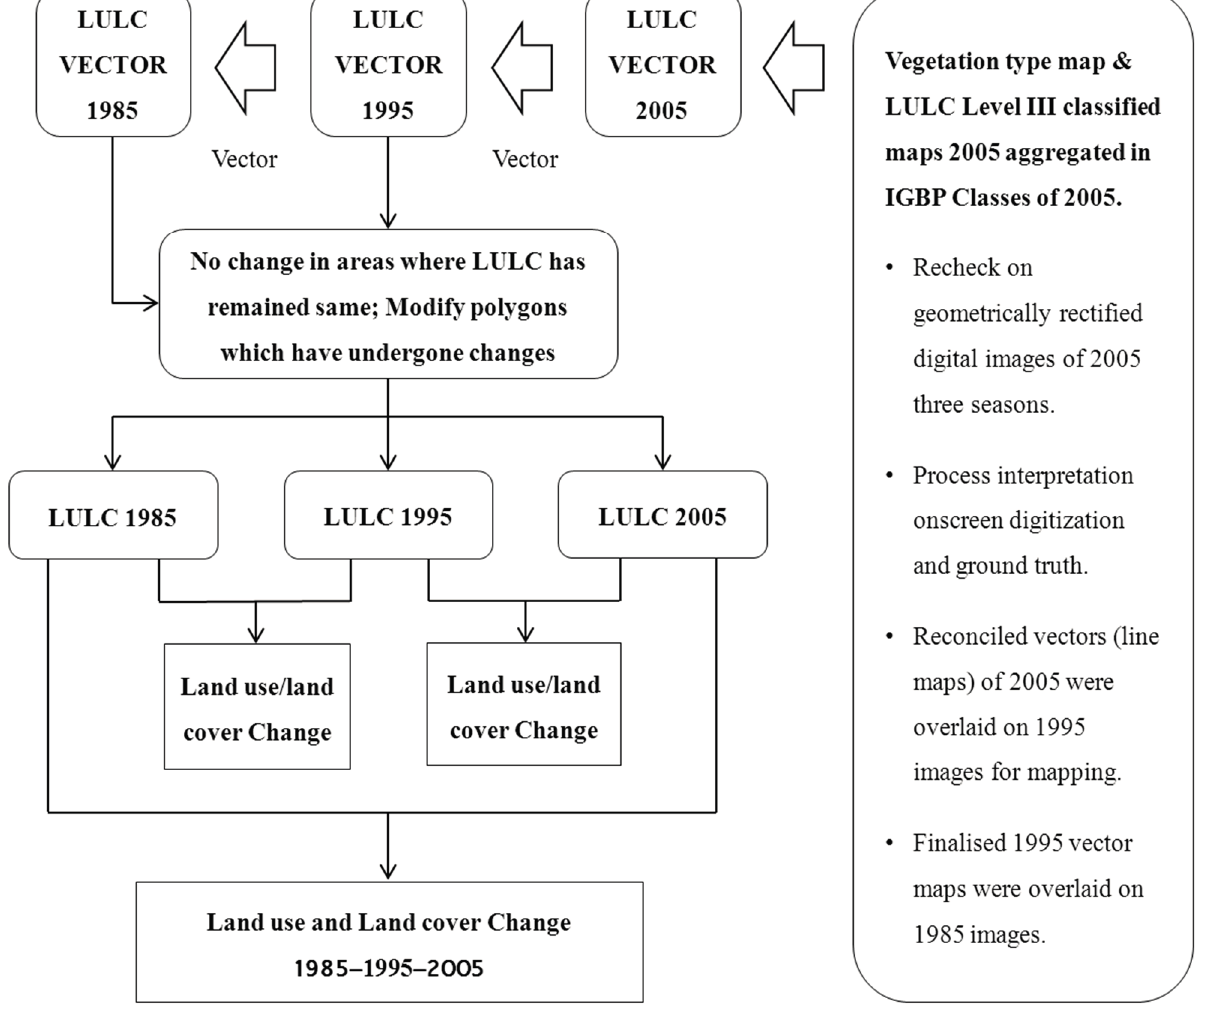
Figure 1. Flow diagram of land use and land cover (LULC) Level-II (IGBP Classification) Mapping using multi-season geometrically co-registered satellite images Satellite